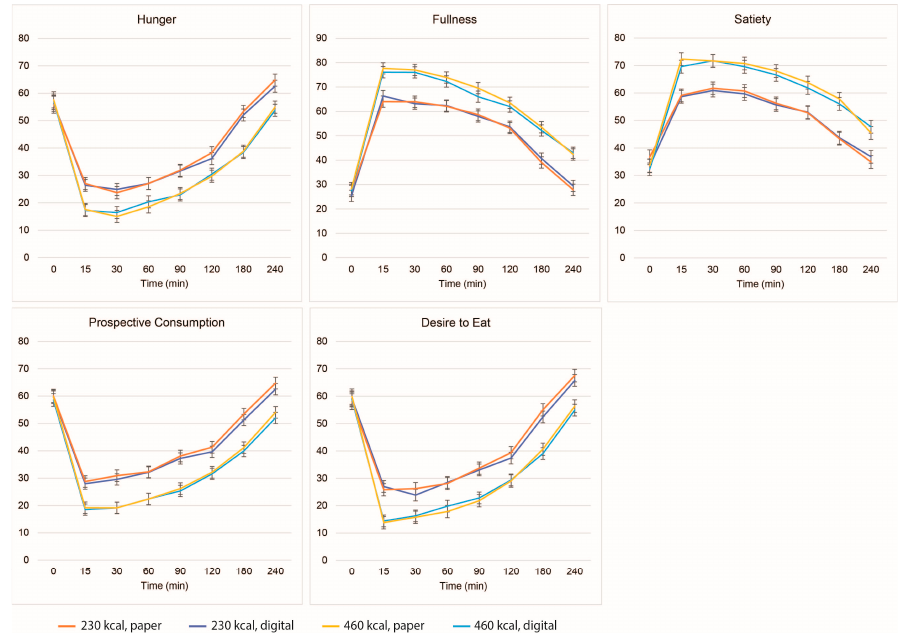
Figure 3. Hunger, fullness, satiety, prospective consumption, and desire to eat (least squares mean ± standard error) following consumption of 230 or 460 kcal breakfast, measured by paper-based or digital visual analog scales.